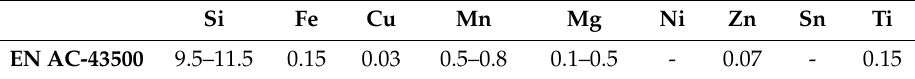
Table 1. Chemical composition of EN AC 43,500 aluminium alloy